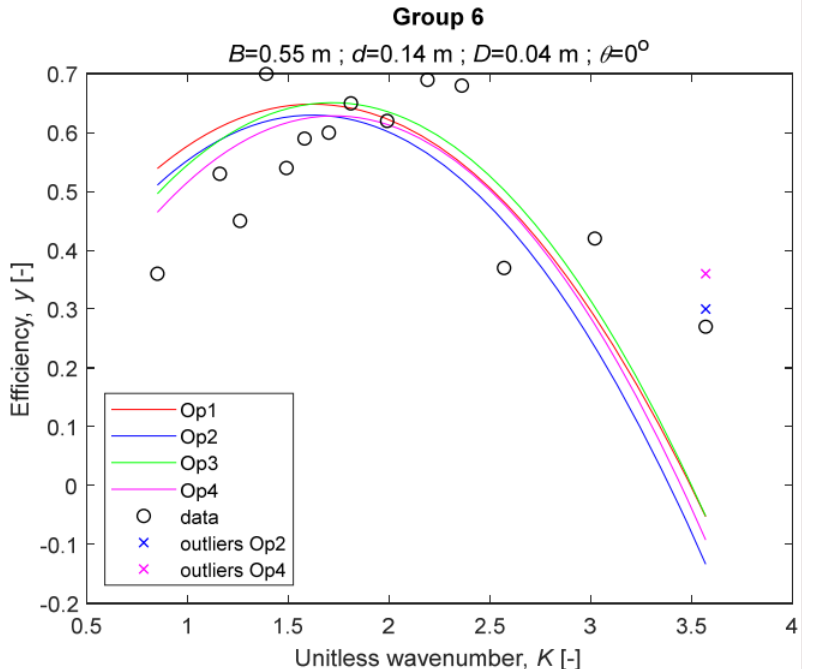
Figure 8. The four models for Group 6. The outliers for a model are denoted above the point with a cross in a respective